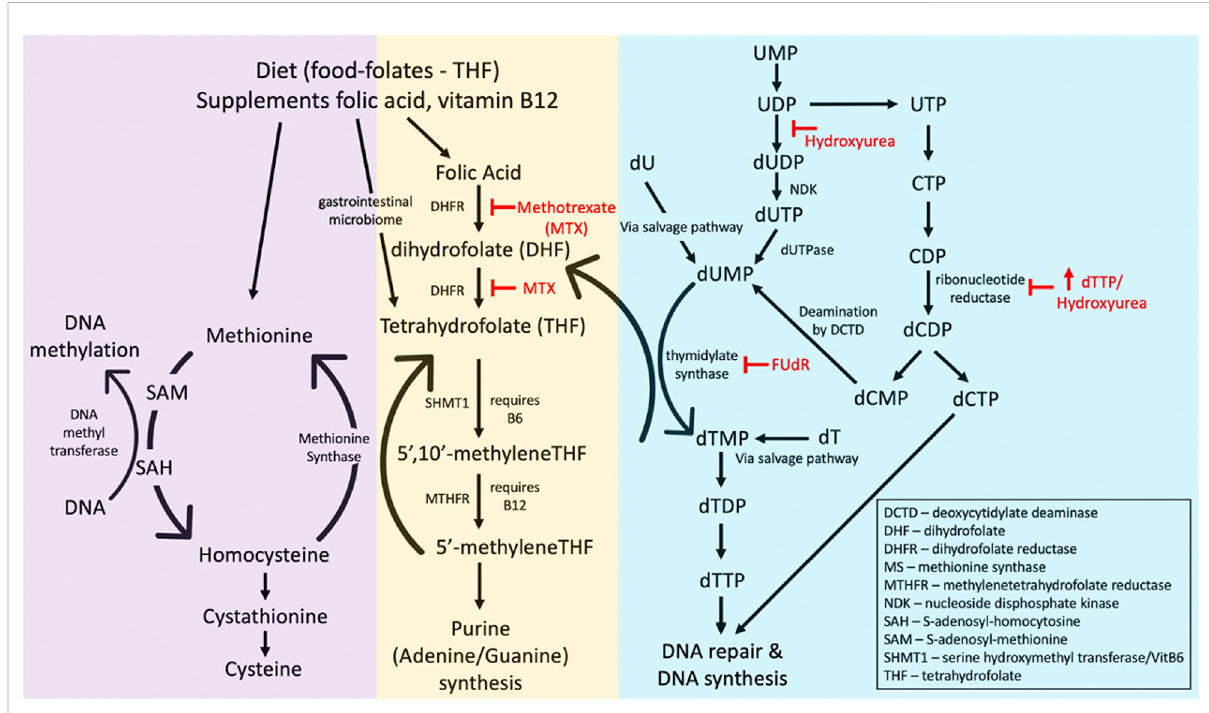
FIGURE 6 The folate metabolism pathway affecting folate-sensitive fragile site expression. Common fragile site inducers methotrexate (MTX), 5 ′ - fl uorodeoyuridine(FUdR),deoxythymidinetriphosphate(dTTP),andhydroxyureaareindicated(inred)astowhatenzymestheyinhibit.Abbreviations of other enzymes or substrates in the pathway are given in the bottom right